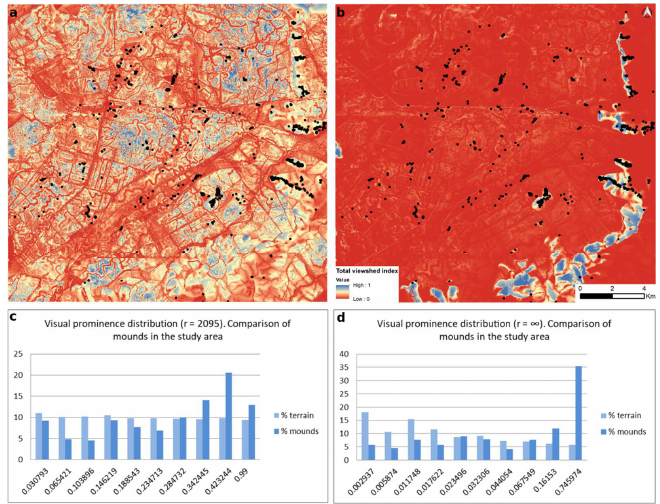
Figure 11. The total viewshed index indicates, for each point of the terrain, the number of points from which it is possible to see the first. The index acquires a value of 1 when it is possible to see a point from all of the points of the terrain, and a value of 0 when it can be seen from none of them. ( a ) From the environment of 2095 m. ( b ) From any point of the study area. ( c ) Graph of visual prom- inence distribution (r = ∞). ( d ) Graph of visual prominence distribution (r = 2095). The calculation shows that the trend is not only to elevate these constructions, but also to make them visible via the election of a prominent area over the environment. The areas of visibility indicate, on the other hand, that the cerritos are also points from which it is possible to have an outstanding visual control of the area. The measurements prove a clear trend towards choosing places with visual prominence for the construction of mounds, independently of the scale of analysis, the complexity of the construction phe- nomenon or other possible factors not analyzed here. 4. Discussion and Conclusions The systematic application of documentation, prospection and analytical procedures has made it possible to significantly increase the number of known mounds in an area of great archaeological relevance known as being the original geographical focal point of this phenomenon. The availability of new data with a higher resolution extended our capacity of detection, even in sites with prior relative mapping, as is the case of Los Ajos, Colina da Monte and Mal Abrigo [35,55], and made it possible to update relevant data in order to propose future spatial analyses on other scales. For the first time in this region, struc- tures such as ponds and small canals were identified within some mound sites, introduc- ing new question marks around the organization, activities and management of the space inhabited by mound-building societies. Archaeological records from the northeast of Uru- guay show that these types of structures have formed part of indigenous technologies for the management of floodable ecosystems. In the Pago Lindo site (department of Tac- uarembó), lagoons and canals recorded within mound sites functioned contemporane- ously with the use and construction of mounds between 3000 and 1000 years BP [50,86]. These features are also present in other mound sites in the valley of the Caraguatá River